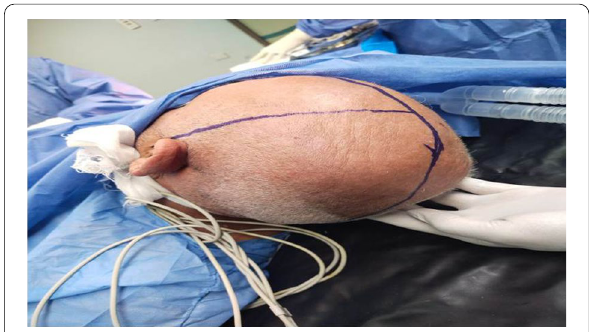
Fig. 2 Anteriorly from the hairline to the inion, the scalp was incised above the sagittal suture with a “T-bar” extension starting 1–2 cm anterior to the tragus at the temporal root of the zygoma and extended superiorly to meet the midline sagittal incision approximately 1 cm behind the coronal suture